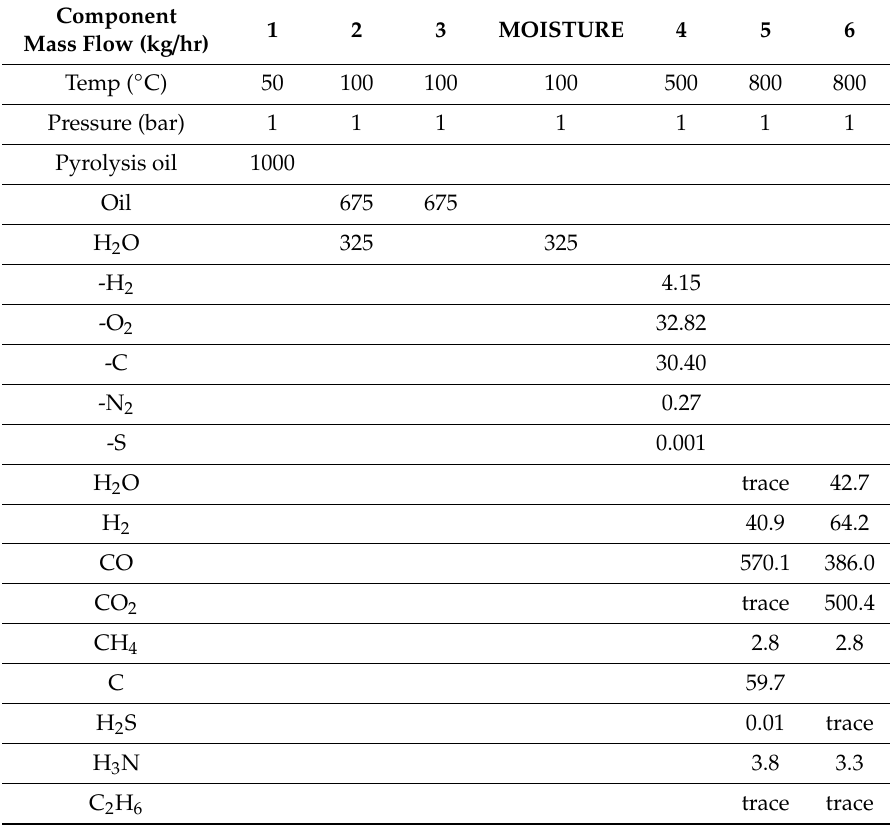
Table A2. Gasification flowsheet in Aspen Plus.